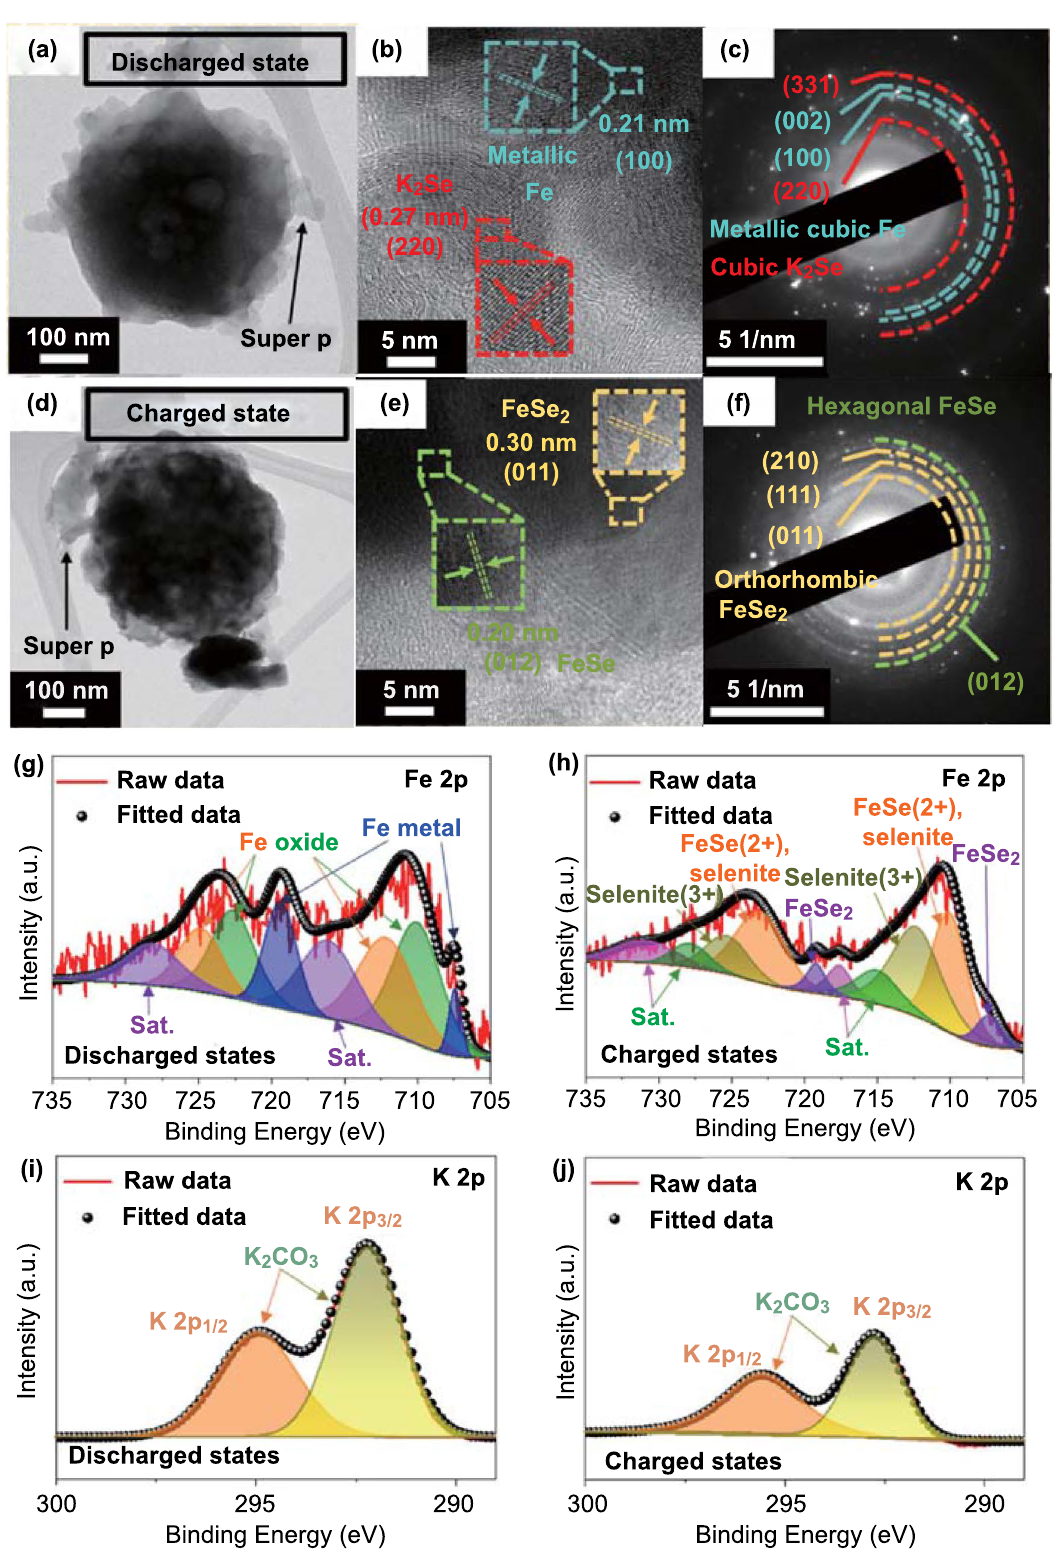
Fig. 5 Ex-situ TEM images, SAED patterns, XPS spectra of FeSe x @C/MB after the first discharge ( a–c, g, i) and charge state ( d–f, h, j ): a, d TEM images, b, e HR‑TEM images, c, f SAED patterns, g, h Fe 2p, and i, j K 2p